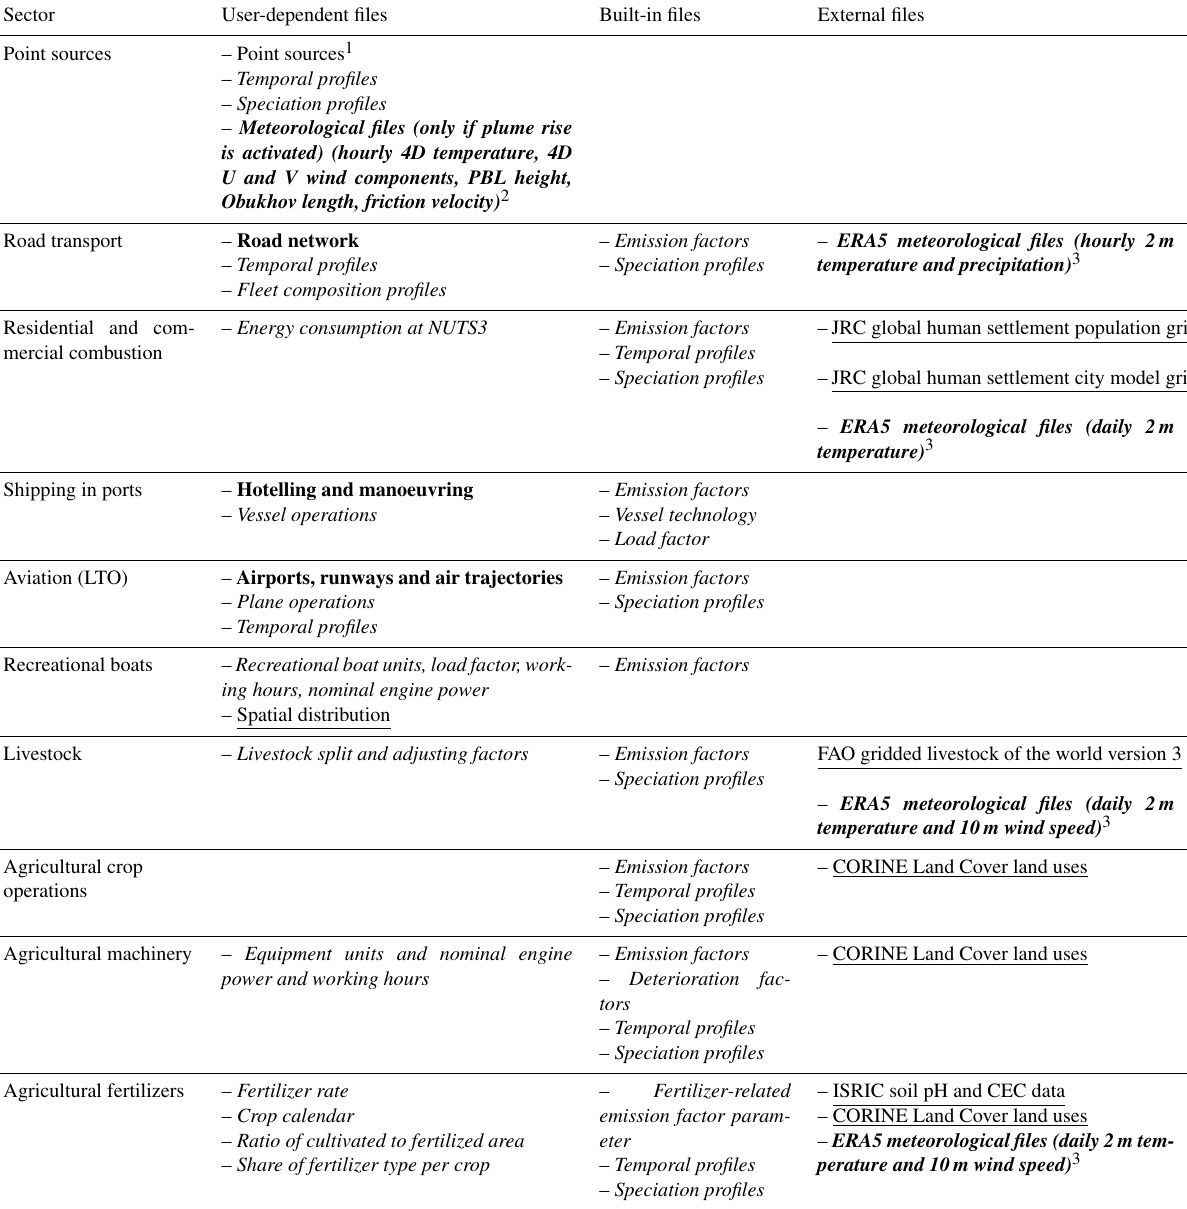
Table B1. Classification of HERMESv3_BU input data files per pollutant